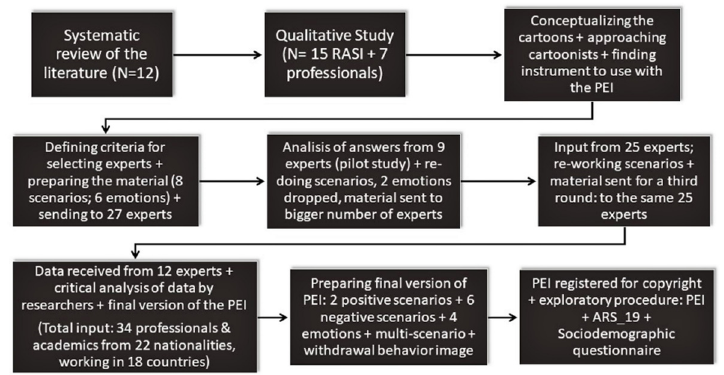
Figure 1. The PEI stepwise building process.